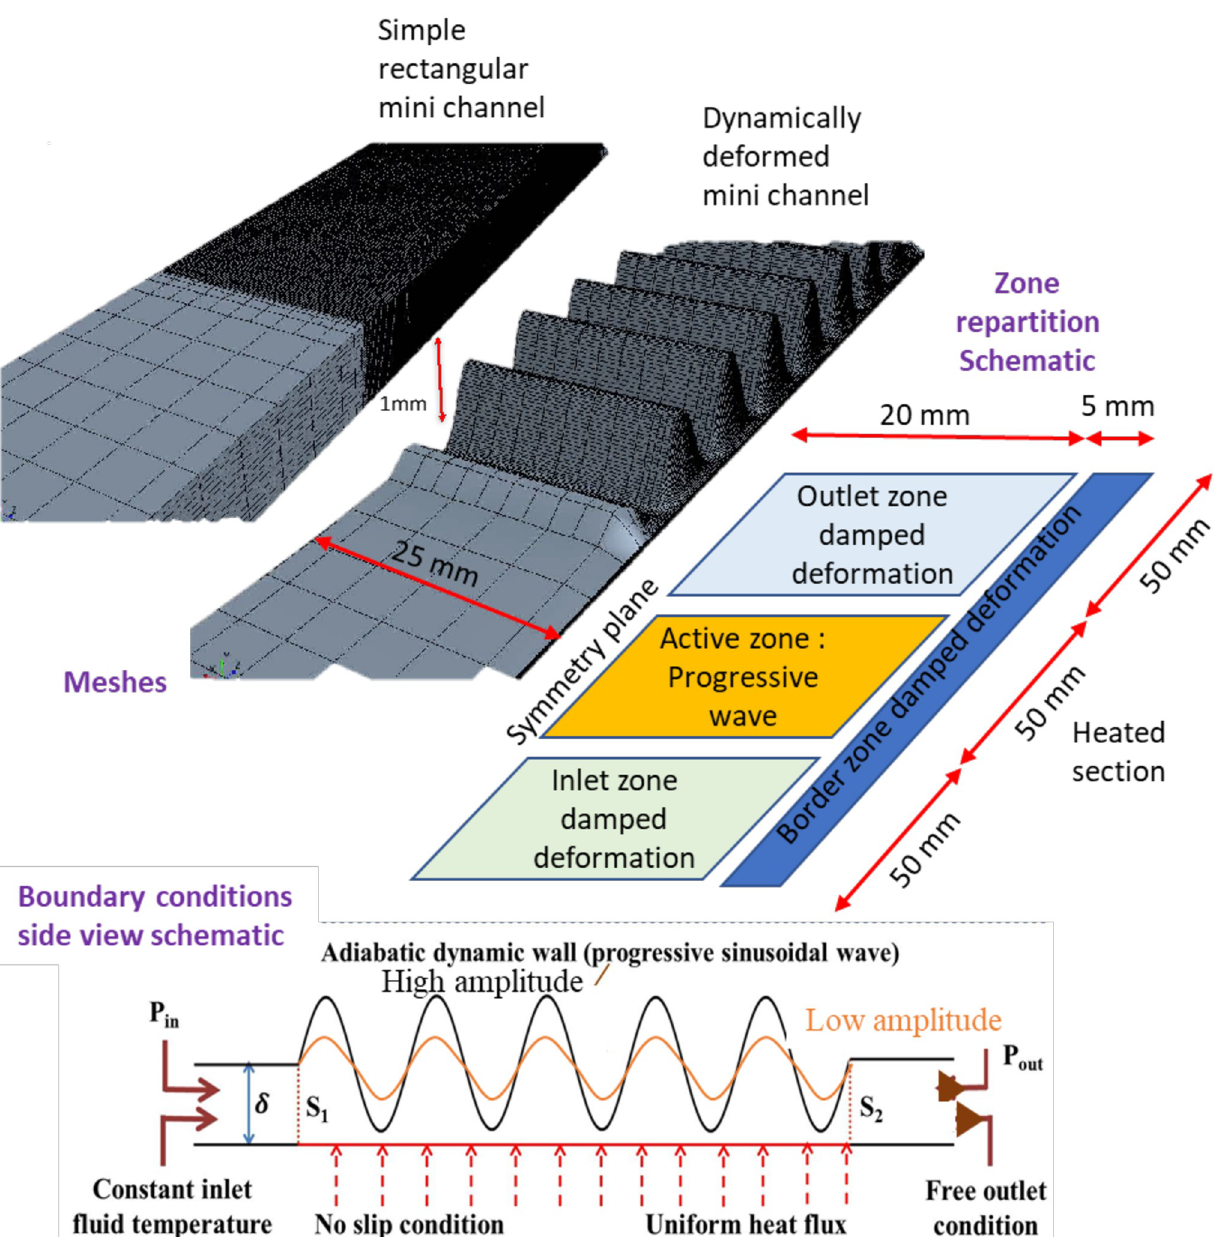
Fig 1. Geometrical and numerical configurations. Top: View of one of the used meshes. The same locations and point of view are kept for both channels. Left: Straight channel (Height 1mm). Right Corrugated channel (Amplitude A 0 = 90%). Vertical scale is magnified 100 times. Center: Top view schematic of the half-channel model. The vertical plane passing through the central axis of the channel is a plane of symmetry, so only half of the channel was simulated (W/2 = 25mm). Bottom: Side view schematic of the DDMC. The lower wall was fixed and subjected to a constant and uniform heat flux over the imprint of heating zone length (length, L: 50 mm, imposed heat power Γ : 125 W) facing the actuated upper wall. A negative pressure difference ( Δ P − P in < 0) is imposed between outlet and inlet sections of the channel, deformed membrane drawn for 2 amplitudes (black and orange). transfer and flow behavior as well as the various operating parameters influences. In the pres- ent configuration (Fig 1) the upper wall and the sidewalls are adiabatic. A no-slip condition is imposed on all the physical walls. The height ( δ ) of the channel, defined as the average distance between the top and bottom walls, is 1 mm while the width (W) of the channel is 50 mm. The